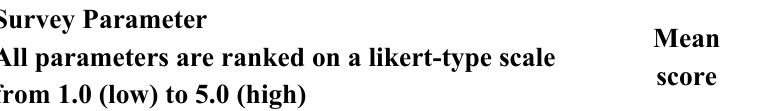
Table 1. Main Numerical Survey